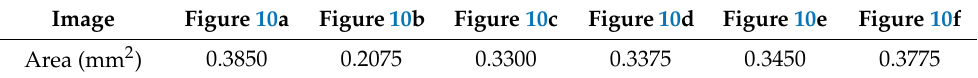
Table 1. The area of high-brightness substance.